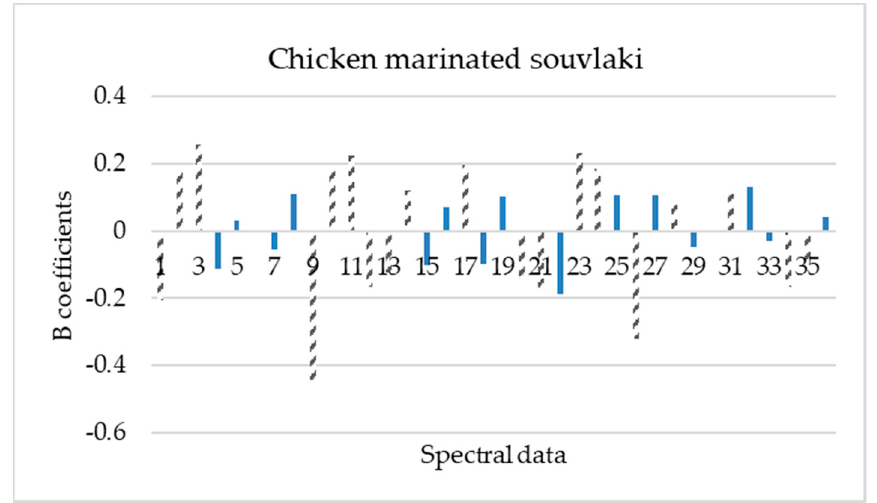
Figure 7. Spectral data (mean and standard deviation) influence (b coefficients) to PLS-R model construction for chicken marinated souvlaki samples. Dashed bars represent data that influenced more the model (1, 19: 405 nm; 2, 20: 435 nm; 3, 21: 450 nm; 4, 22: 470 nm; 5, 23: 505 nm; 6, 24: 525 nm; 7, 25: 570 nm; 8, 26: 590 nm; 9, 27: 630 nm; 10, 28: 645 nm; 11, 29: 660 nm; 12, 30: 700 nm; 13, 31: 850 nm; 14, 32: 870 nm; 15, 33: 890 nm; 16, 34: 910 nm; 17, 35: 940 nm and 18, 36: 970 nm).